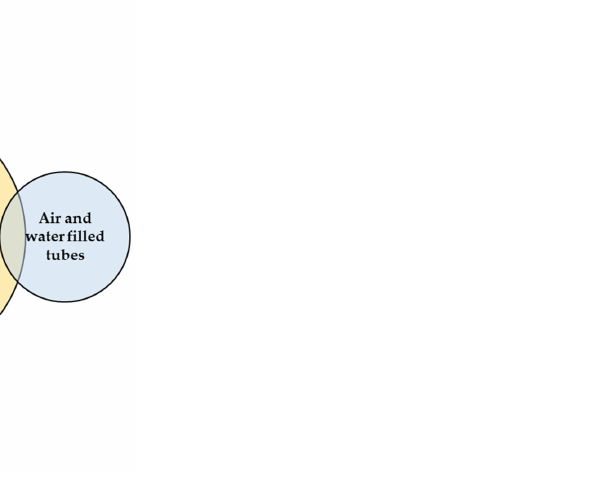
Figure 1. Classification of temporary flood protection systems, derived from Ogunyoye and van Heereveld [6]. Climate change is resulting in intensive and frequent events and transformations. Global warming is not only happening, there is scientific consensus that it is intensifying. As part of a concerning future climate, experts predict that extreme flooding will become more prevalent worldwide, with average sea levels projected to rise by over a meter by the end of the century [7–9]. Higher sea levels enable waves to carry greater energy to shore, which regularly exercises flood defences [10]. This further highlights the im-